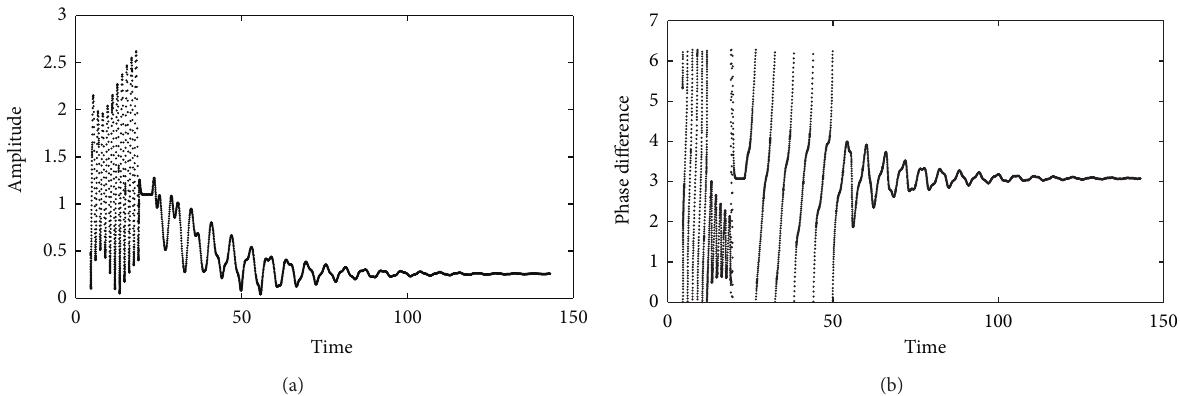
Figure 6: Control result at 𝜔 = 2.1 . Time history of (a) the radial displacement amplitude and (b) phase difference.